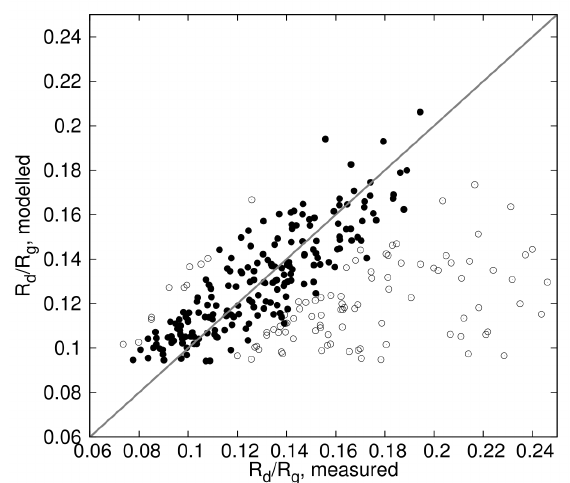
Figure 3. The modelled vs. measured diffuse fraction of global irradiance (SMEAR Estonia, 2016). Closed symbols represent the criterion of clear sky based on diffuse and global irradiance ( R g , meas /R g , mod > 0 . 9, R d , meas /R d , mod > 0 . 8), the closed sym- bols and the open symbols combined represent the criterion of clear sky based on global irradiance ( R g , meas /R g , mod > 0 . 9). The solid line illustrates the ideal 1 : 1 ratio between the modelled and mea- sured data